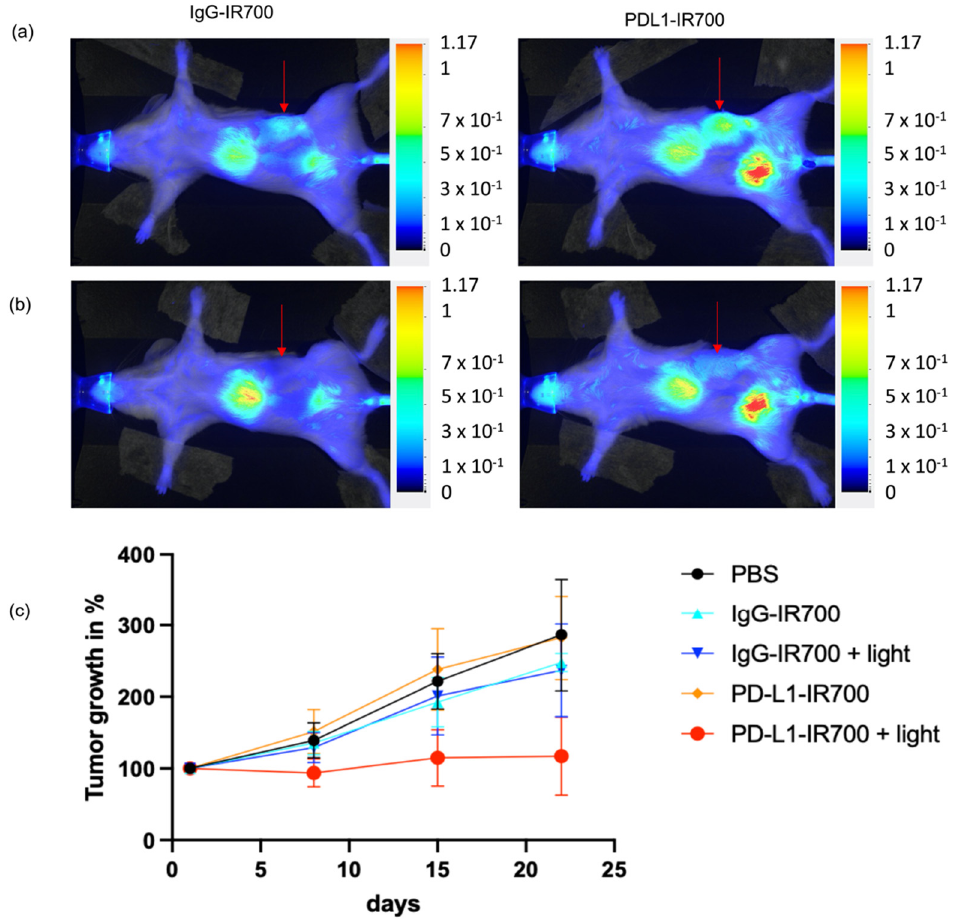
Figure 5. NIR images of representative ID8-Defb29-VEGF orthotopic tumor- (marked by arrow) bearing mice 24 h post injection of IgG-IR700 (left column) or PD-L1-IR700 (right column), before ( a ) and immediately after ( b ) photoirradiation. Normalized tumor growth of ID8-Defb29-VEGF orthotopic tumors treated with PBS ( n = 5), IgG-IR700 ( n = 3), IgG-IR700 + light ( n = 8), PD-L1-IR700 ( n = 5), PD-L1-IR700 + light ( n = 8) ( c ).